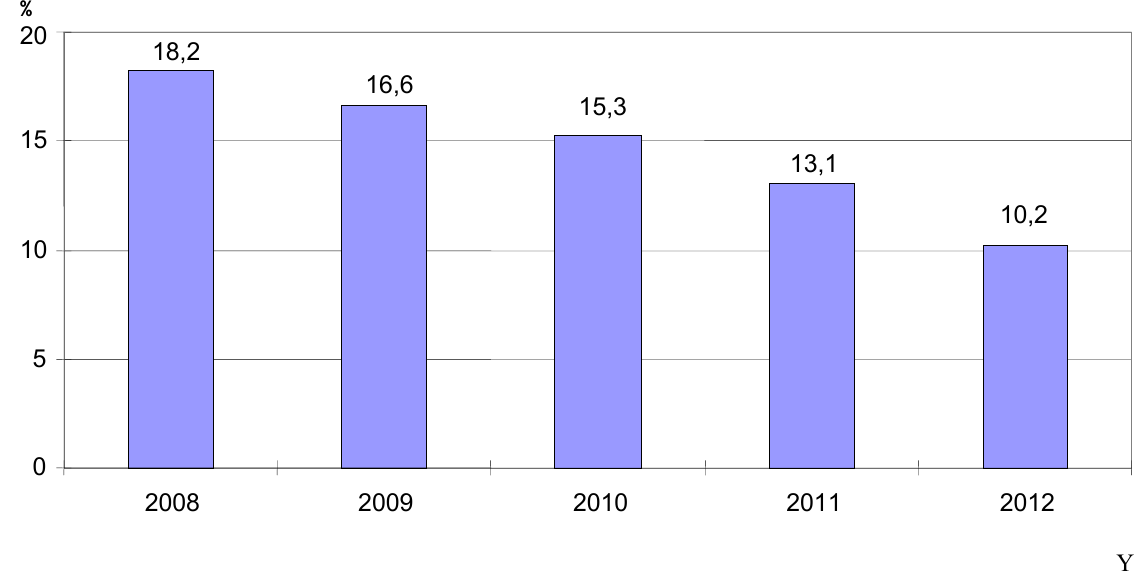
Fig. 1. Percentage of healthy pupils in period 2008-2012, %